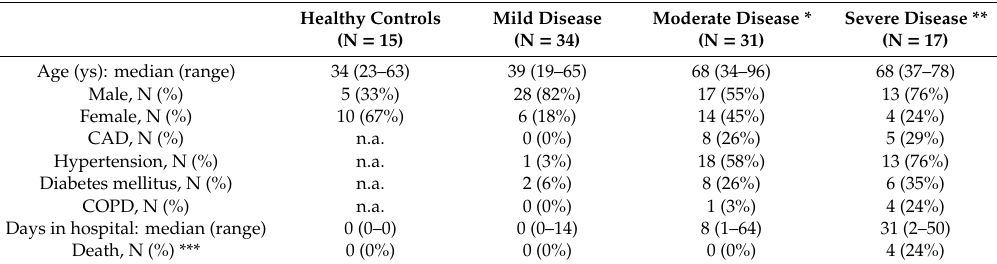
Table 1. Characteristics of blood